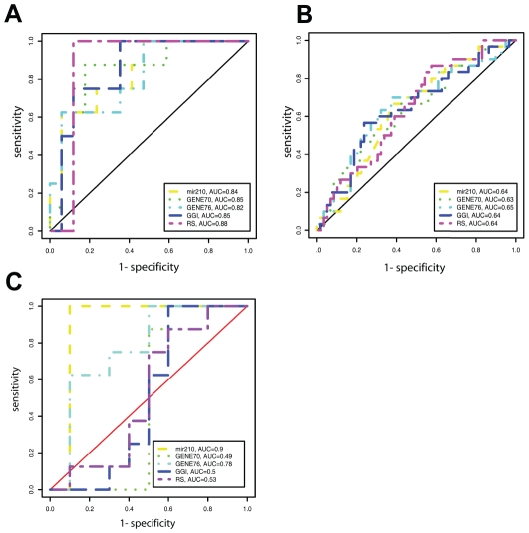
MiR-210 shows similar prognostic performance to multiple genes signatures.Time-dependent receiver operating characteristic curves for miR-210 expression, the gene expression grade index (GGI), the 70-genes signature (GENE70), the 76-genes signature (GENE76) and the estimated 21-gene recurrence score (ONCOTYPE) for relapse-free survival. (A) Systemically untreated ER-positive population (N = 25); (B) ER-positive tamoxifen-treated population (N = 89) and (C) ER-negative untreated population (N = 18). Areas under the curves are shown beneath the curves.